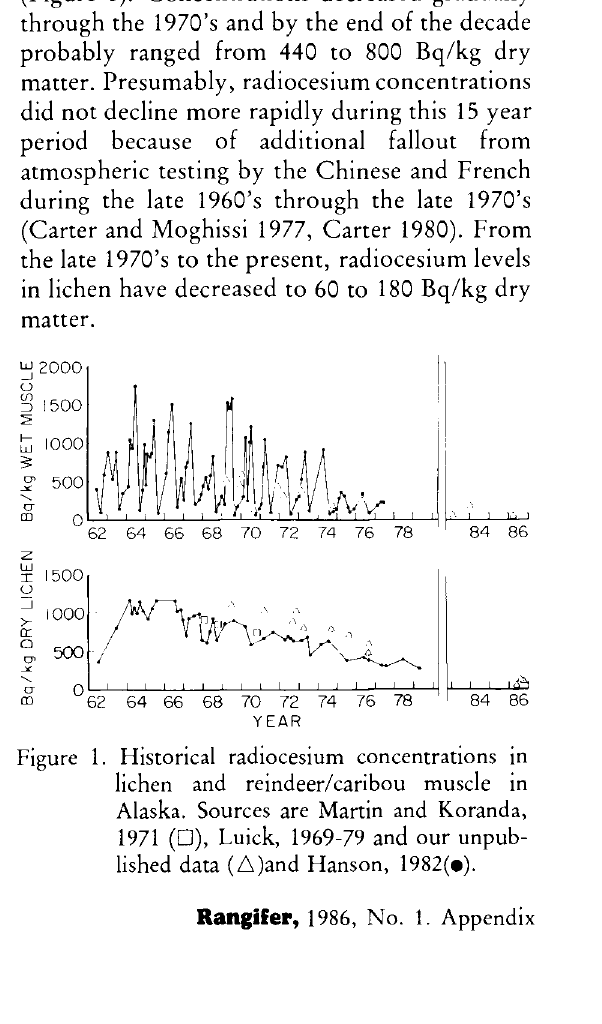
Figure 1. Historical radiocesium concentrations in lichen and reindeer/caribou muscle in Alaska. Sources are Martin and Koranda, 1971 (•), Luick, 1969-79 and our unpub lished data (A)and Hanson,